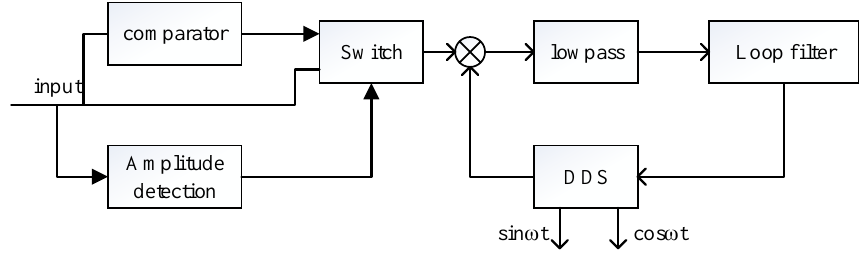
Figure 7. Phase control loop with quick frequency locking.